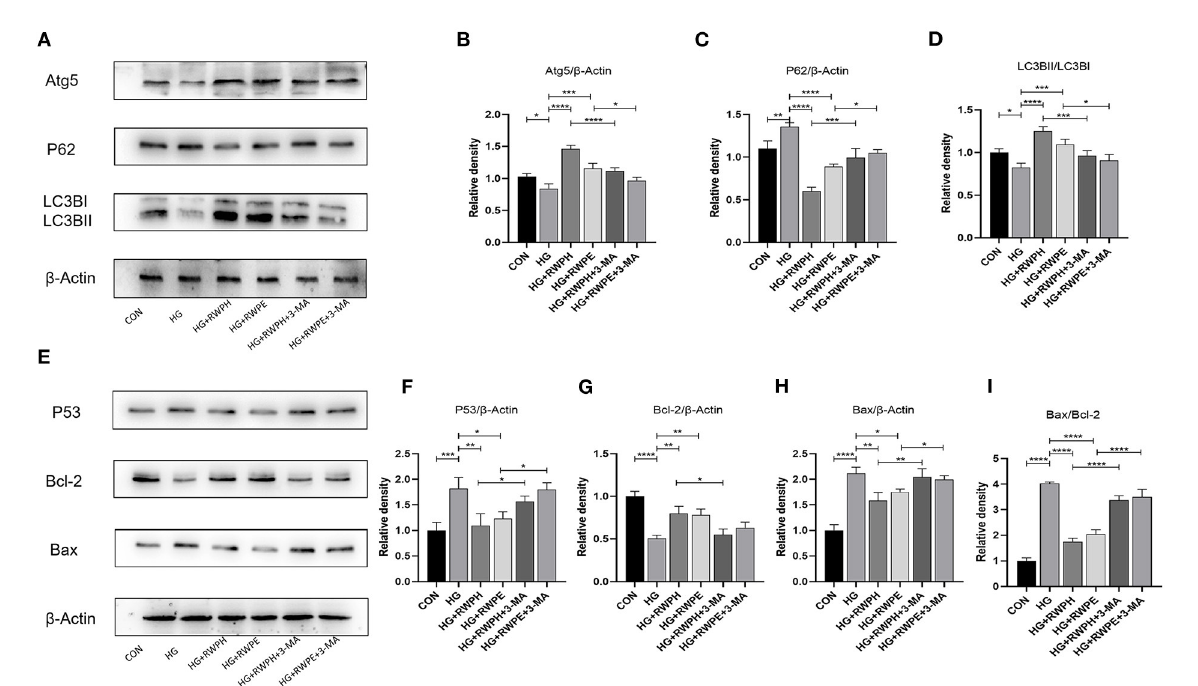
FIGURE5 Autophagy inhibitor was able to counteract the anti-apoptotic effects of RWPH and RWPE. (A–D) Western blot analysis of the relative protein expression of ATG5, P62, and LC3B in each group. (E–I) Western blot analysis of the relative protein expression of Bcl-2, P53 and Bax in each group. * P < 0.05, ** P < 0.01, *** P < 0.001, and **** P <